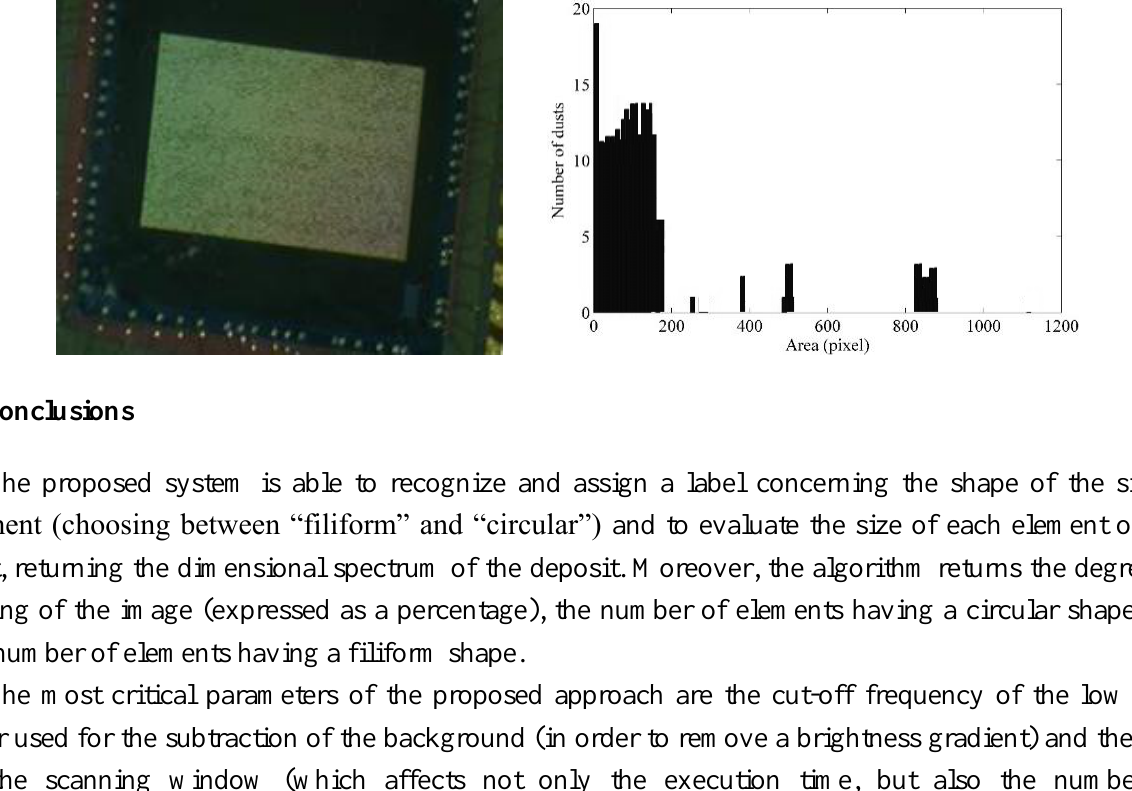
Figure 11. The sensor during the laboratory test and the resulting amplitude